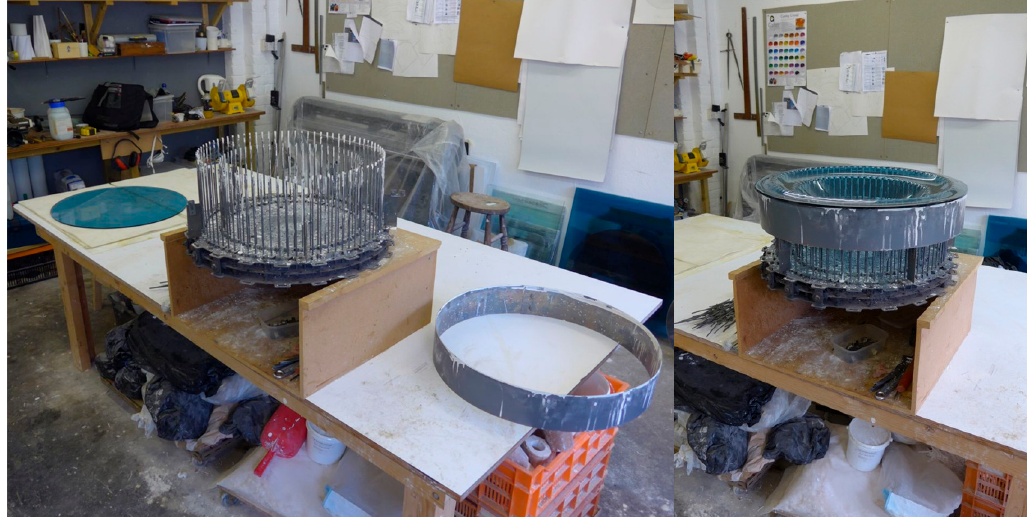
Figure 11. The second stage of the creative explorations of the glass RPT system, utilising the RPT system's underlaying circular array geometry to create bowls using sets of pins positioned in concentric circles, (photo: Jorgensen, T. 2013).